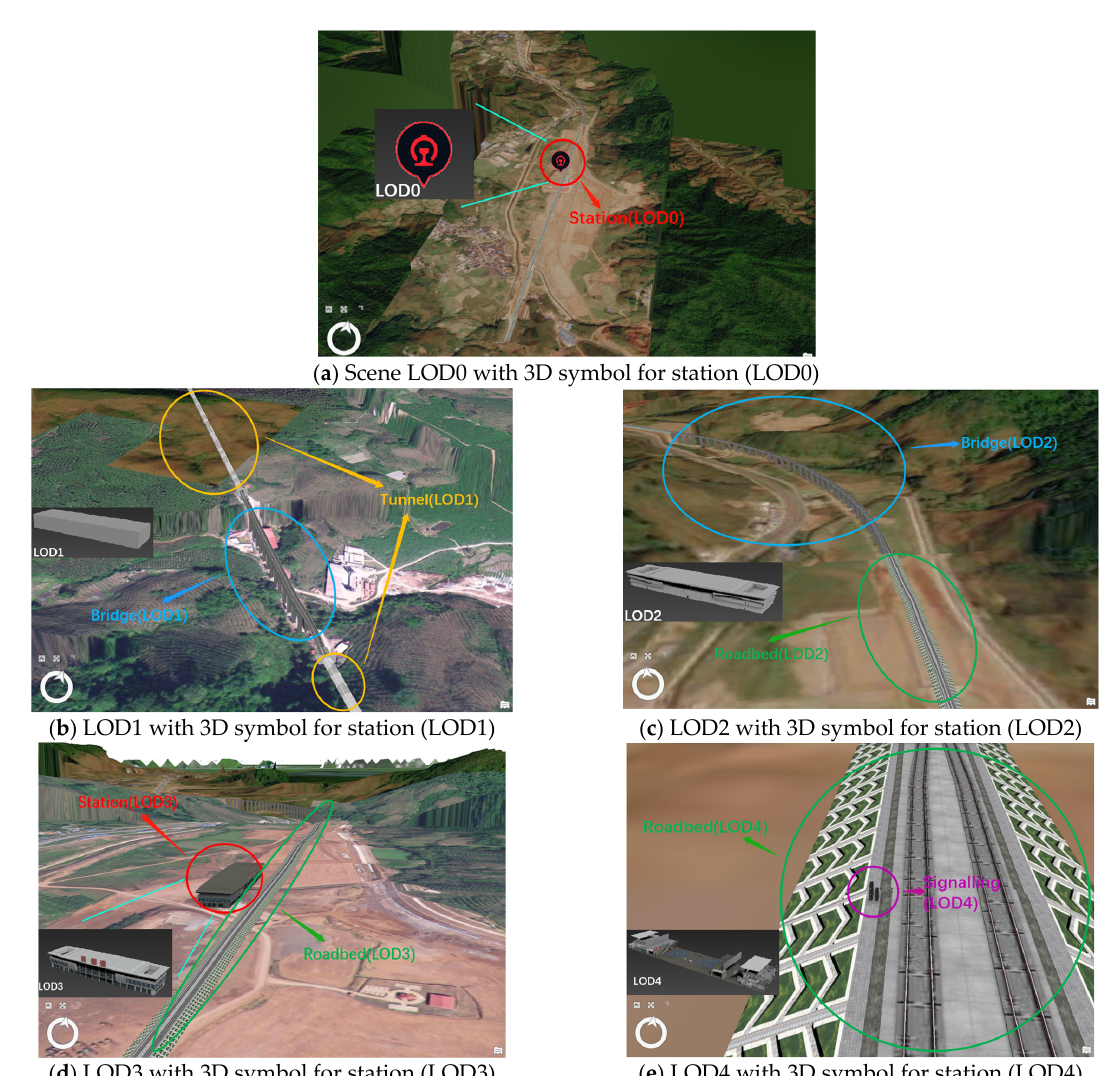
Figure 8. Multi-scale representation of symbolic 3D railway scenes: ( a ) LOD0: Only geographic en- tities with object importance level 5 were loaded, containing stations in the route and tunnels at some junctions. The symbolic accuracy was at the lowest level of detail. ( b ) LOD1: Three-dimen- sional symbols of tunnels and some bridges are present in the scene. The accuracy of the 3D symbols at this level was improved compared to the previous level. ( c ) LOD2: In addition to the previously loaded stations, tunnels, and bridges, at this level of detail, some of the roadbeds out of junctions and turning points were loaded. The roadbeds were generally connected to the bridges. The 3D symbols at this level of detail had a clearer outline and colour. ( d ) LOD3: At this level, all the road- beds are shown. The whole road was fully loaded, consisting of the tunnel, bridge, and roadbed stitched together. The 3D symbol structure at this scale was complete and well textured, especially the station model. ( e ) LOD4: At the highest level of detail scenes, all 3D symbols were at their highest accuracy. The 3D symbols of the signalling machines on the route were also loaded. These symbols were reproduced to the greatest extent possible for the real scene.